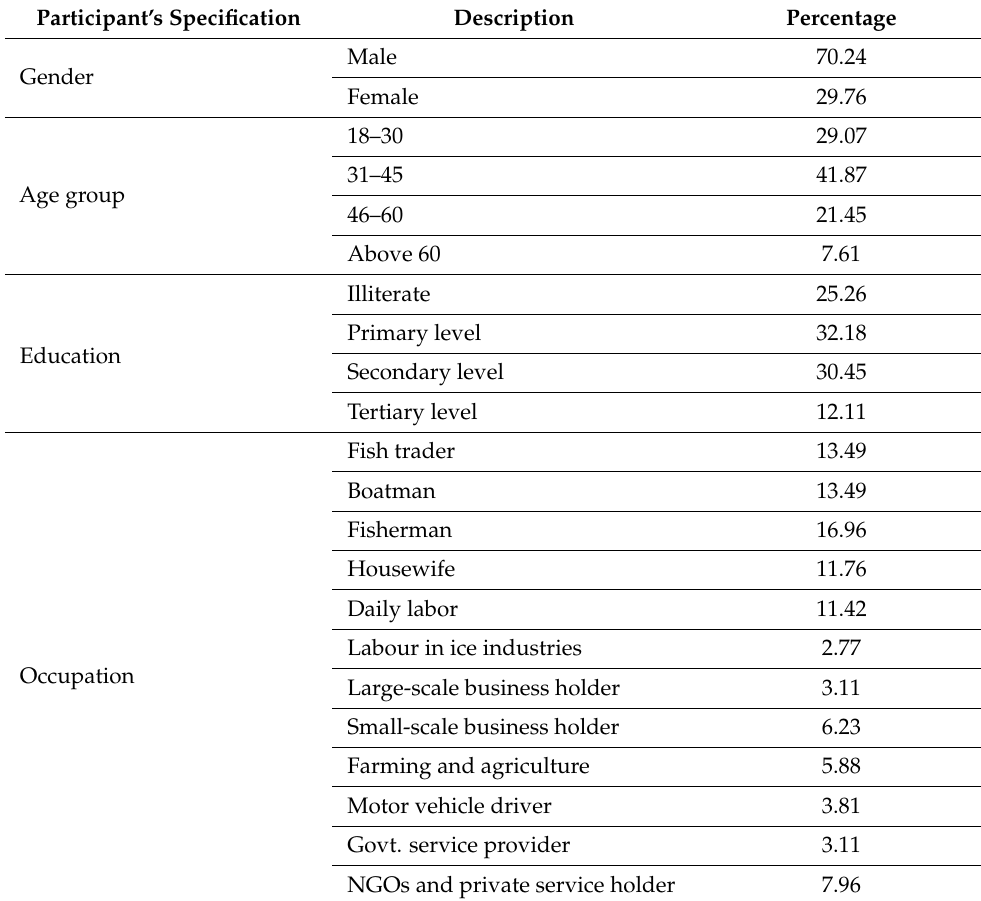
Table 5. Major specifications of participants in the survey.